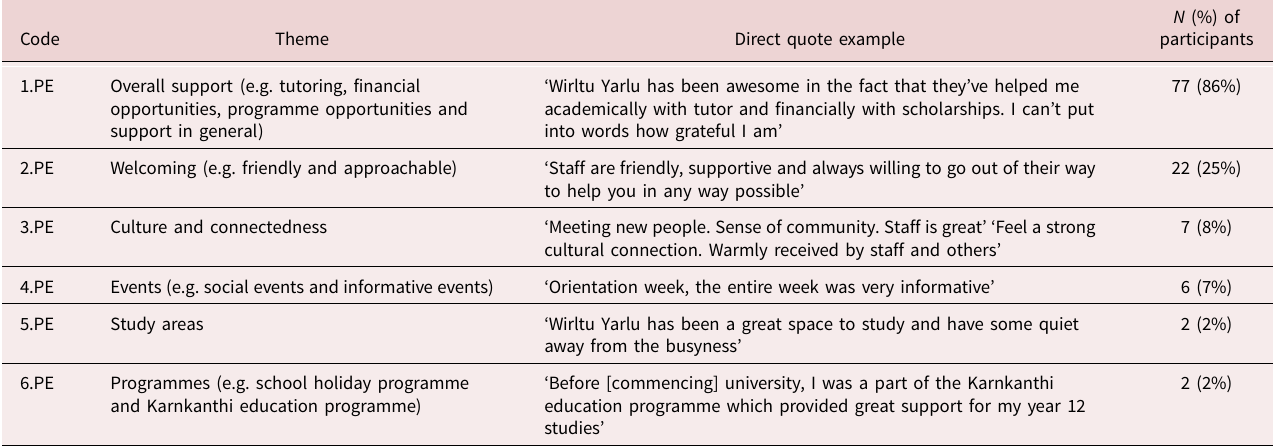
Table 2. Content analysis of positive experiences with Wirltu Yarlu ( N =90)